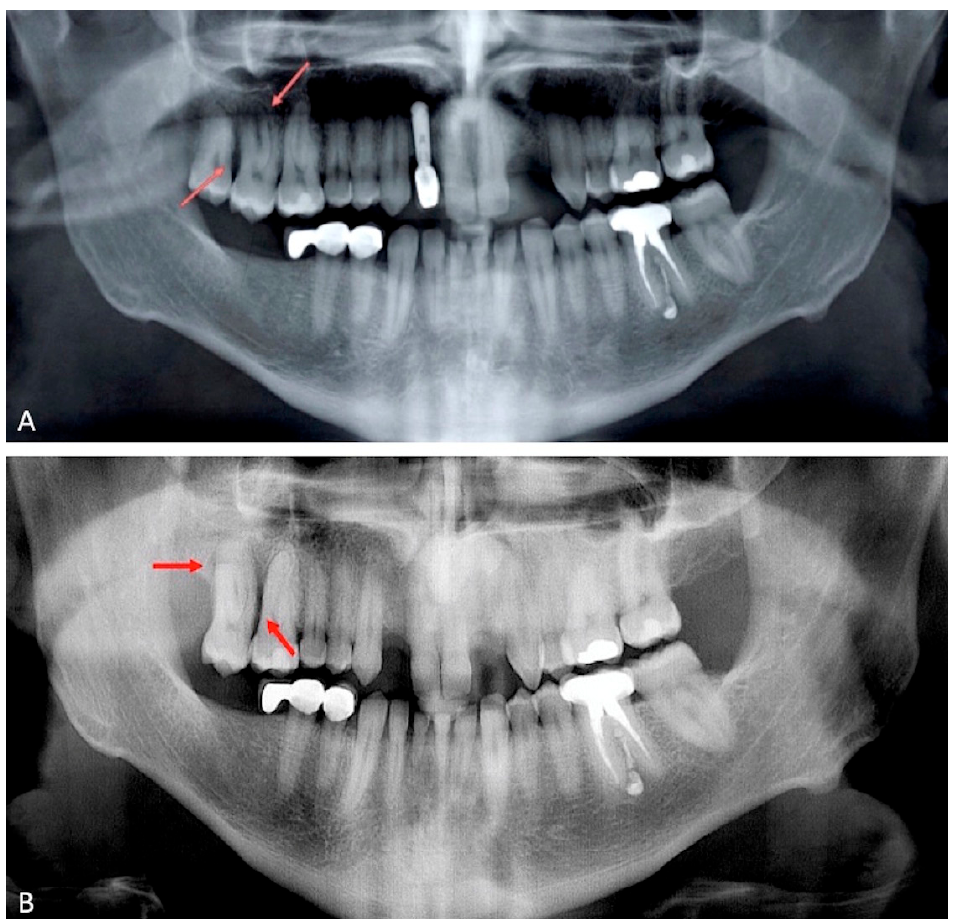
Figure 2. Orthopantomography of 2018; bone defects were not observed between 1.6. and 1.7. (panel A ). Orthopantomography repeated in 2021. A severe horizontal bone loss and absence of tooth decay were observed. A horizontal radiolucent line in the third apical root was present (panel B ). Red arrows indicate the lesions.